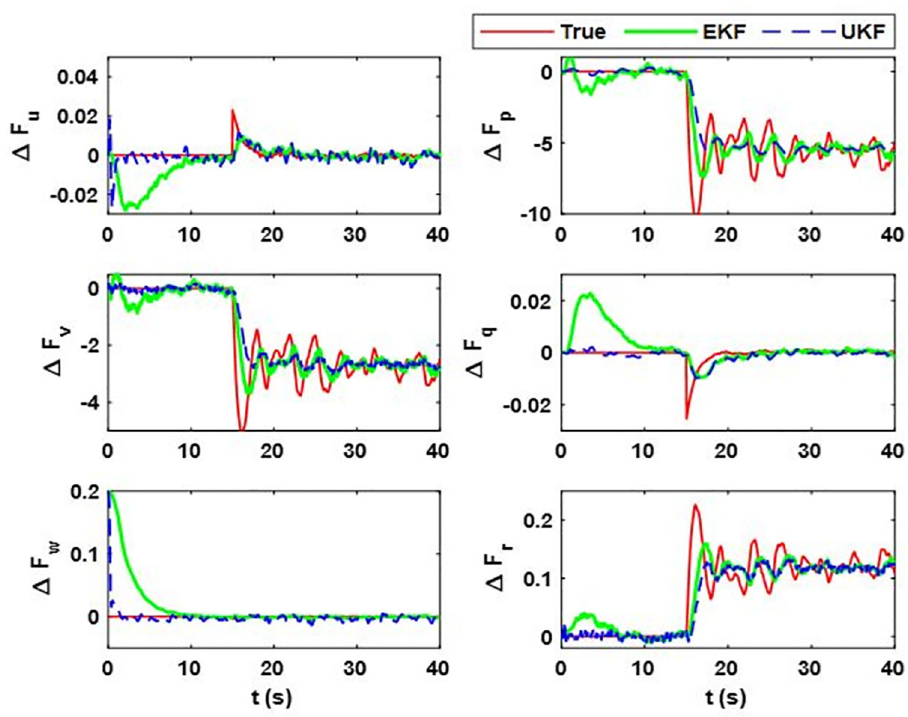
Fig 7. Estimation of model uncertainty and disturbance vector. In this case, it estimates the total effect on airship body axes’ linear and angular acceleration due to the variations that occur in the airship mass matrix. (i) Δ F (iii) Δ F v ; (iv) Δ F q ; (v) Δ F w ; (vi) Δ F r